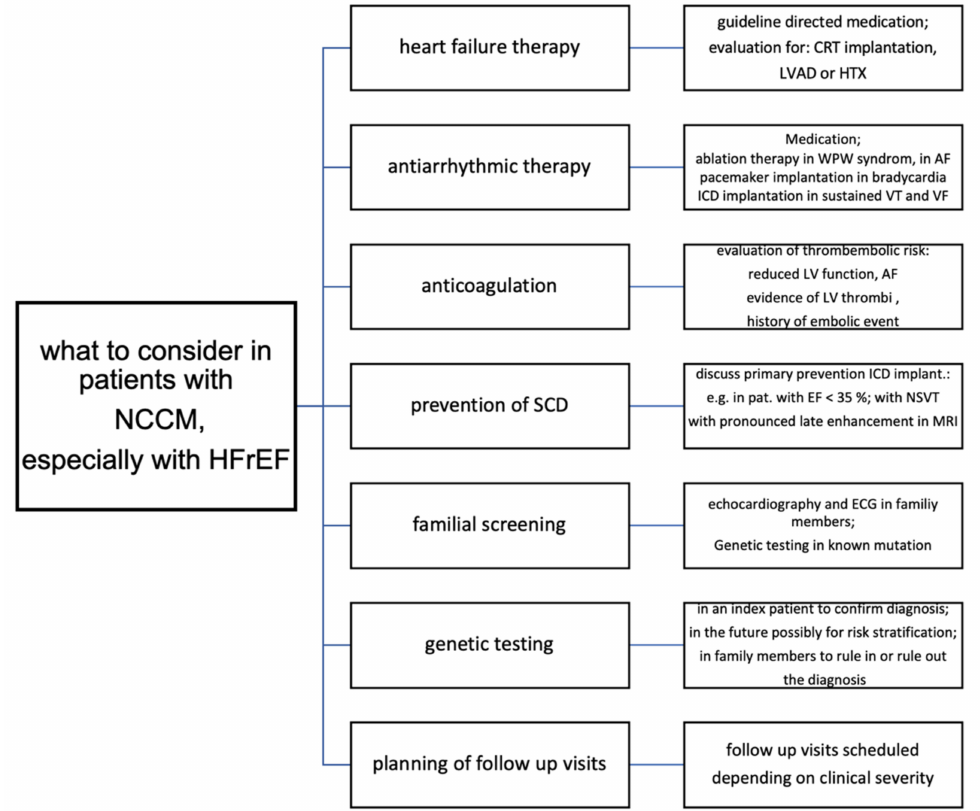
Figure 6. Treatment algorithm for patients with